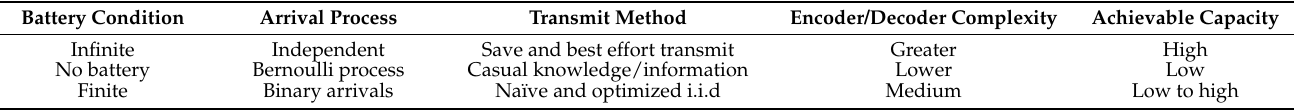
Table 2. Comparison of energy arrival, transmit, encoder complexity, and capacity for infinite, finite, and no battery. Battery